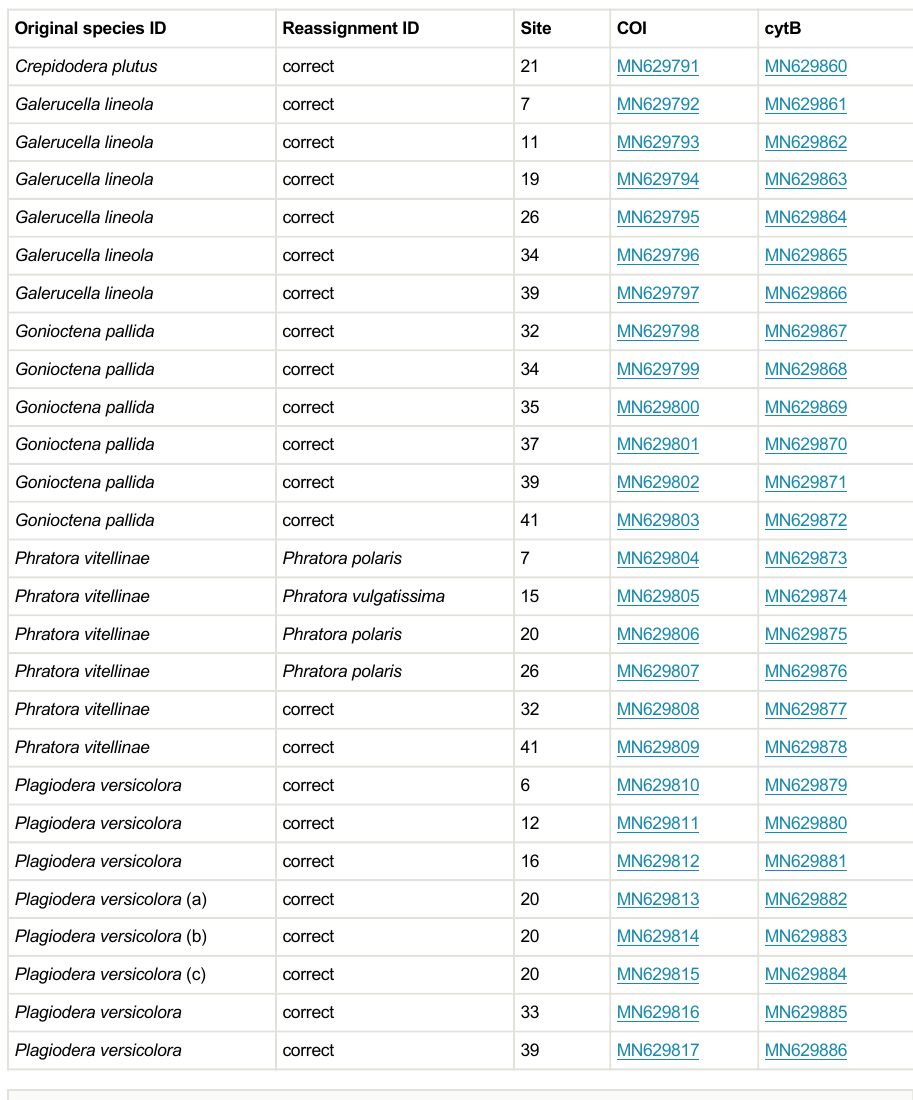
Table 3. GenBank sequences included in the phylogenetic analysis. The sample in bold under Phratora polaris was downloaded from GenBank as P. tibialis